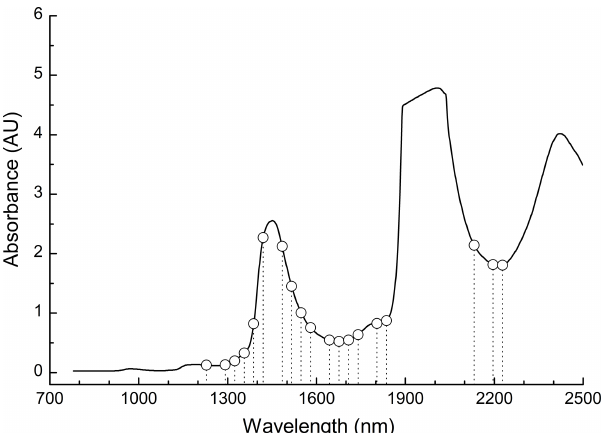
Fig. 4. Wavelength position of the selected optimal WSP-PLS model in the average spectrum.